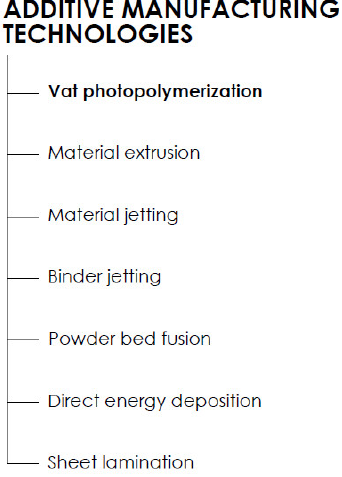
Figure 1. Division of the additive manufacturing (AM) technologies according to ISO/ASTM 52900: 2015 Additive Manufacturing—General Principles—Terminology.